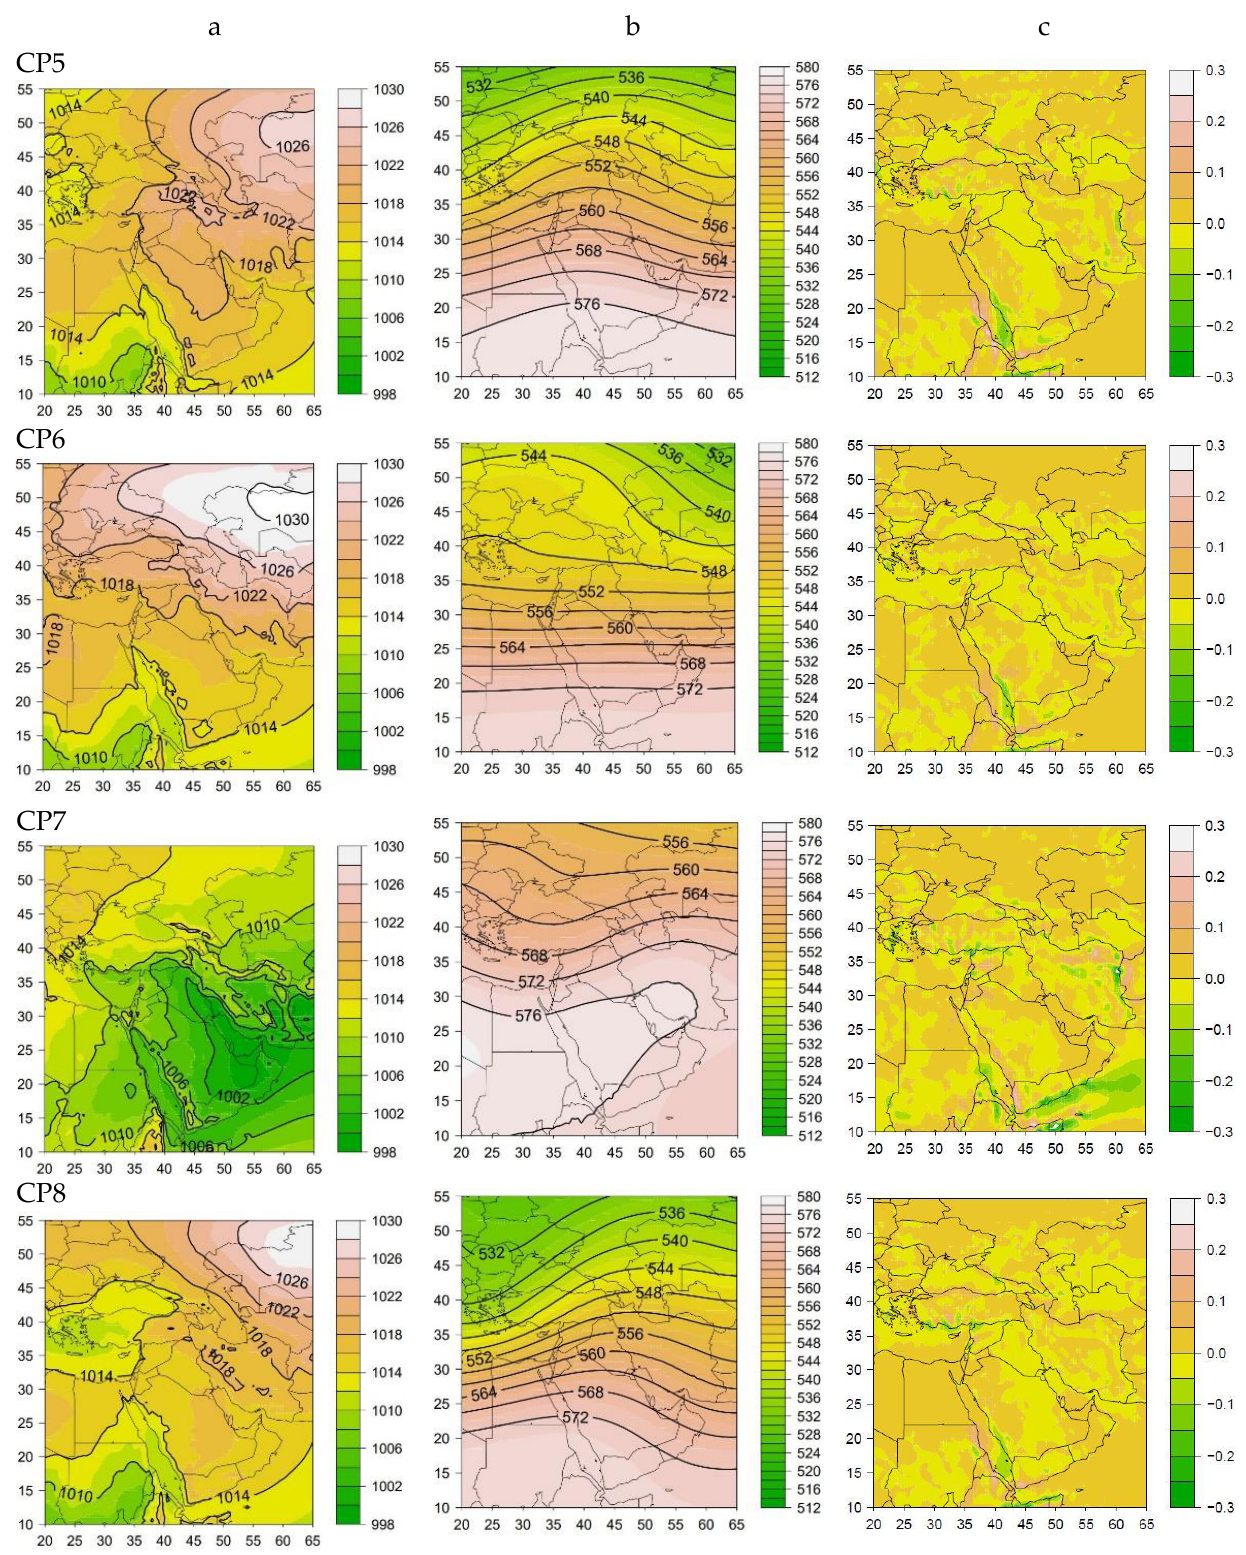
Figure 3. As in Figure 2, for patterns 5 – 8. Circulation pattern 9: An Eastern European high pressure with a center of 1024 hPa is in the west of the Black Sea and is penetrating Iran from the west of the Caspian Sea. In other parts of the country, relatively low pressure is established. In the middle level, a deep trough with a positive slope is in the north of the Caspian Sea towards the east of Turkey and then stretched to the north of the Red Sea. The gradient of contours is rela- tively high, between latitudes of 25° to 45°. The moisture flux pattern shows convergence in the south of the Red Sea, northeast of the Mediterranean Sea, and most parts of Iran. During the activity of this pattern, the establishment of wet weather conditions and pre- cipitation in most parts of the country (except southwest), especially the northwest, west, southwest, and central Zagros, are predicted. Circulation pattern 10: In the surface map, a low pressure (1010 hPa) is located at the south of the Red Sea and toward Iran ’ s west and southwest borders. In the atmosphere, the middle level is associated with a deep trough that stretches from the north of the Black Sea to the middle part of the Red Sea, and Iran, the western half, is located in the east of this trough. Moisture flux convergence is in the south of the Red Sea, east of the Mediter- ranean, and in the west, southwest, and parts of southern Iran, with a maximum value of − 0.11. Therefore, gradually wet events will be happening in those areas, and with the mid- level trough progress to the east, central, southern, northeastern regions, and east of the country. Circulation pattern 11: With the spread of Siberian high pressure to lower latitudes, most Iran, eastern Turkey, Iraq, Saudi Arabia, and the eastern Mediterranean have been affected by relatively high pressure. A weak trough is passing through the east of the country. The moisture flux pattern shows relatively weak convergence in the southern Red Sea and southwestern Turkey. With the establishment of this pattern, dry events are predicted in most parts of the country; however, relatively humid conditions will occur in the eastern part of the country. Circulation pattern 12: The southern, central, and eastern parts of Iran affected by the Red sea extended low pressure. At the mid-level of the atmosphere, cut-off low (540 hPa) is over the Black Sea, and the trough stretches from the Black Sea to the southern Medi-